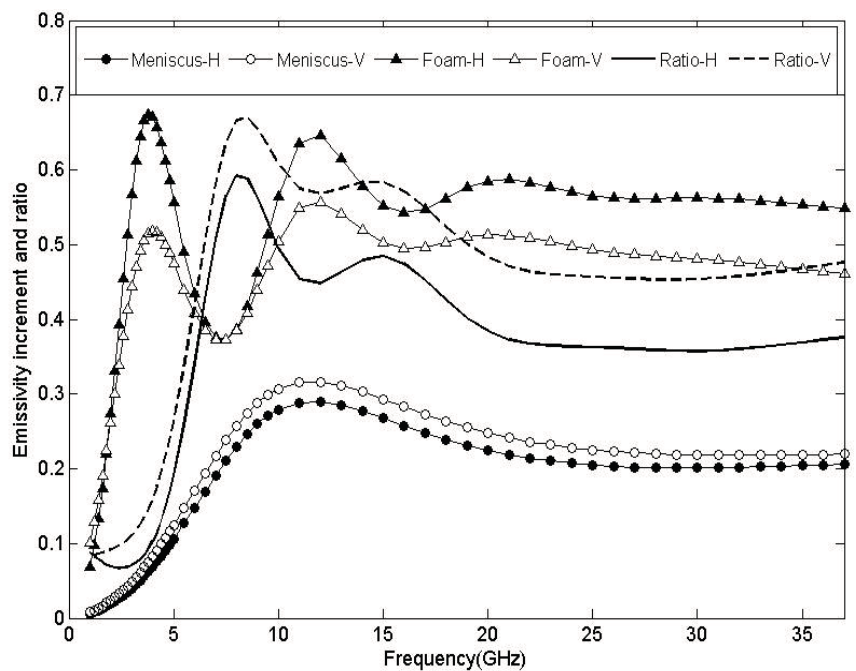
Figure 6. Emissivity increments induced by foam layer (thickness 1.3 cm and AVF 0.9) and meniscus zone (thickness 1.5 mm and AVF 0.5236) calculated by RM emissivity model. Their ratios vary with microwave frequency, where SST = 0.5 °C, SSS = 34 psu, and incidence angle =